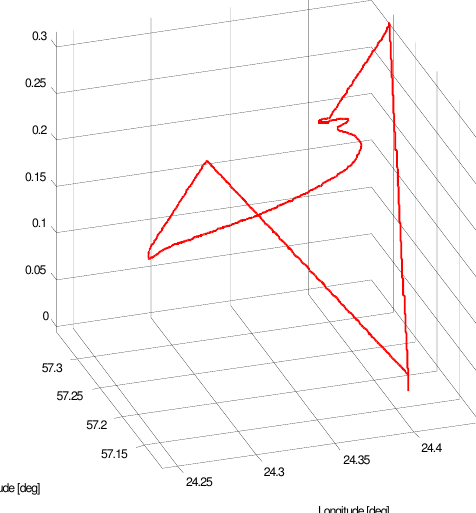
Fig 13. A very simple PID-based velocity control. Maintains given airspeed by opening/closing throttle. Desired airspeed obtained from lookup table prepared by user